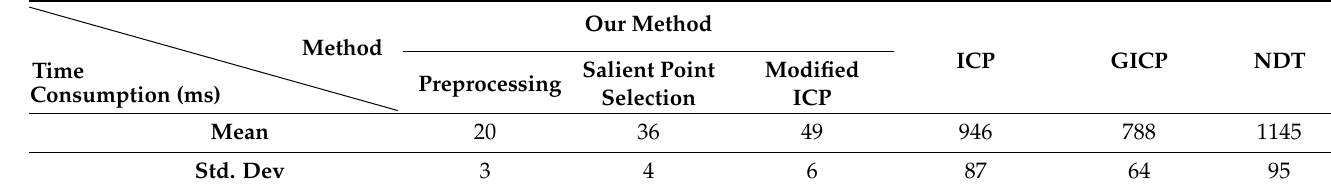
Table 4. Comparison of amount of computation for different